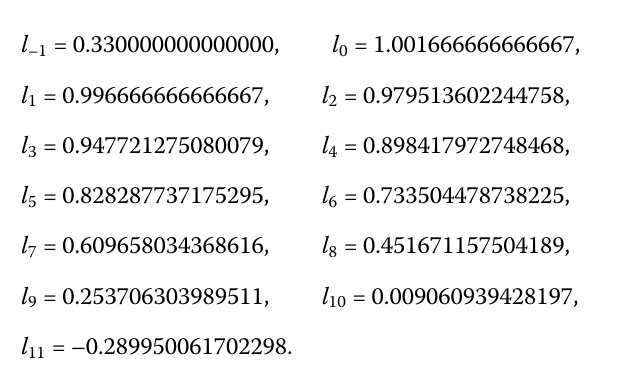
thirteen unknowns l i where i = –1,0,1,...,11